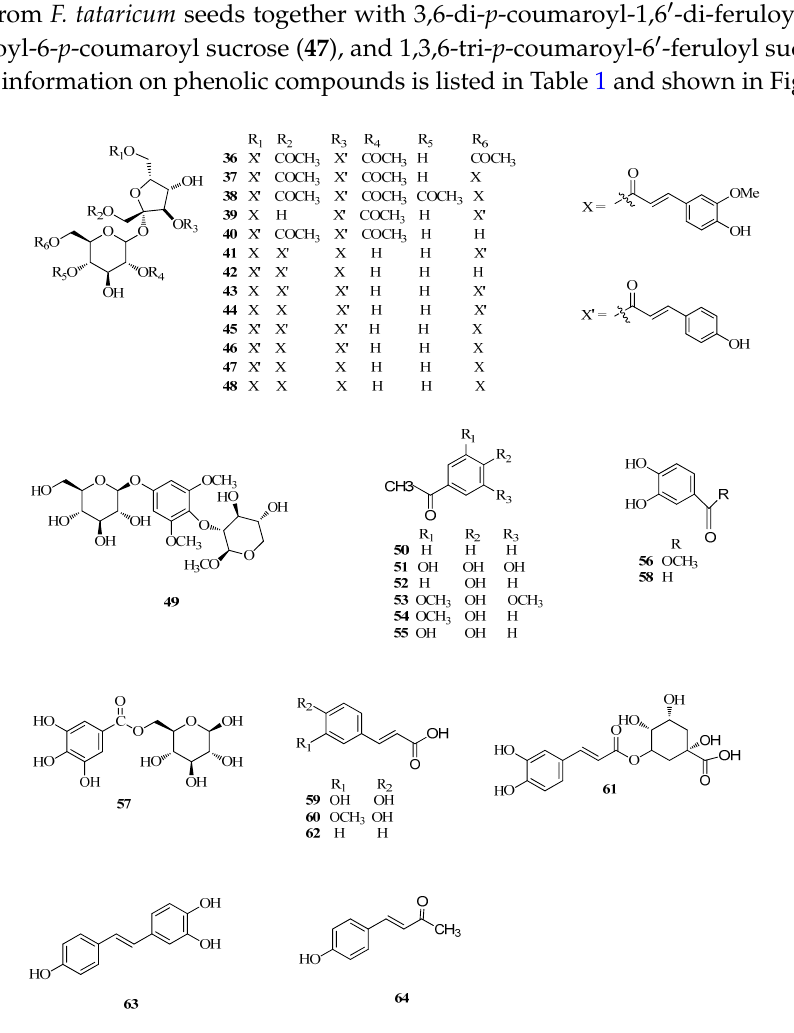
Figure 2. Structures of tannin compounds isolated from F. esculentum , F. tataricum and F. diabotrys .